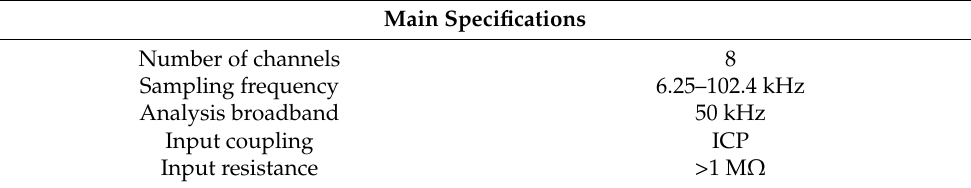
Table 2. INV3062S data acquisition instrument.